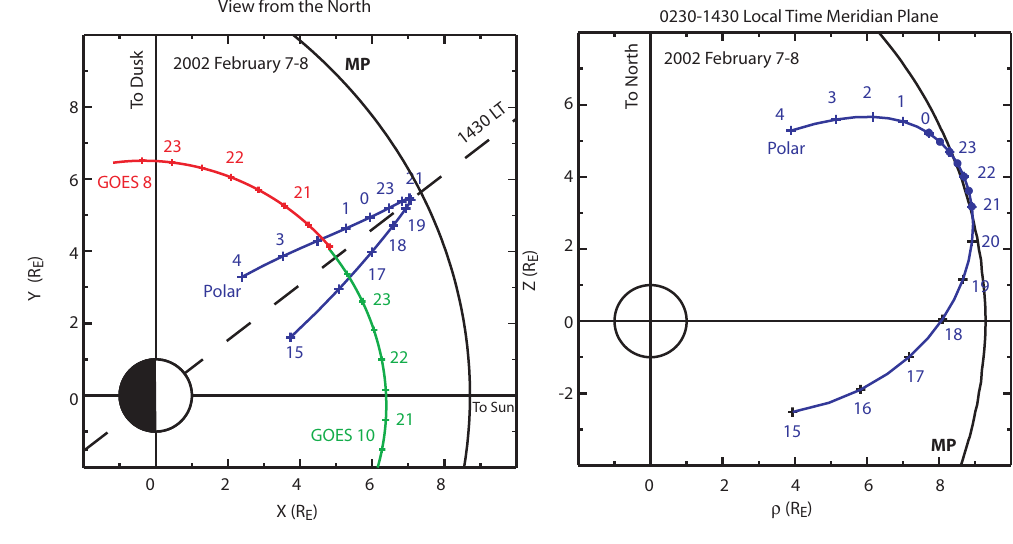
Fig. 3. Spacecraft trajectories in the magnetosphere during the time of interest on 7 February 2002. The left panel shows the model magnetopause (black) and orbits of Polar (blue), GOES 8 (red) and GOES 10 (green) projected in the GSM XY-plane as viewed from the north. The right panel shows the Polar trajectory and the model magnetopause in the 14:30 LT meridian plane. The solid symbols mark each 30-min interval along the trajectory during time of